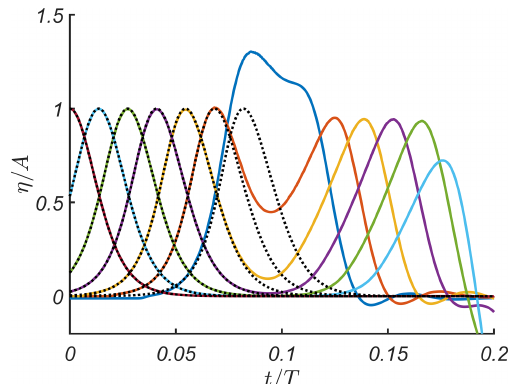
Figure 7. Maximum run-up height, R max /A , as a function of ini- tial effective wave length, λ/X 0 (blue axes) and kh 0 (black axes). Analytical solutions for tan α = 1 : 20 and tan α = 1 : 50 are shown by dotted and dashed lines, respectively, while numerical simula- tions for tan α = 1 : 20 and tan α = 1 : 50 are shown by circles and crosses, respectively ( A/h 0 = 0 . 03).